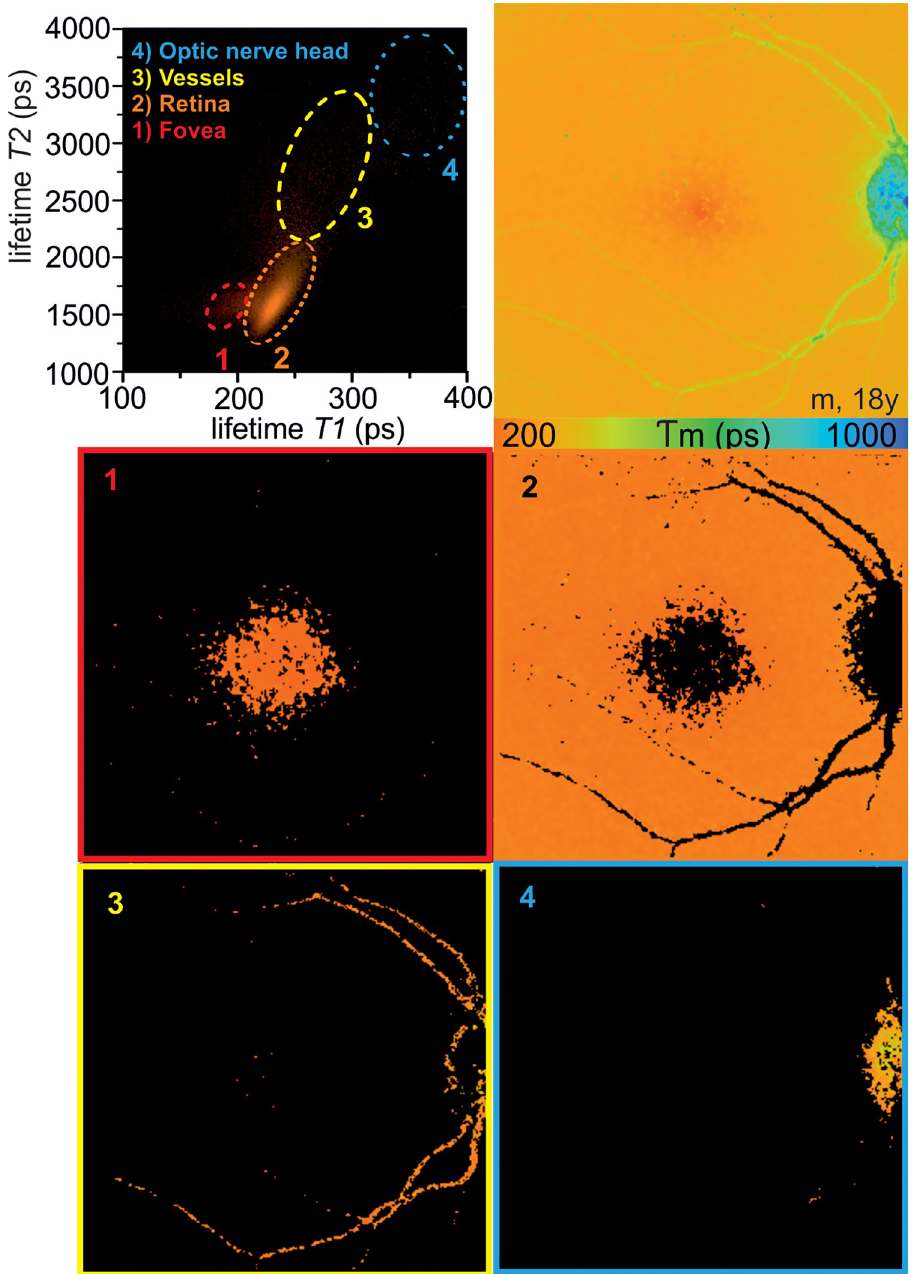
Fig 5. Scatter plot of fluorescence lifetime parameters. The scatter plot represents an illustrative way of depicting the interaction between the short and the long decay component within each channel. Data are shown for the long spectral channel of a phakic subject. Similar scatter plots were observed in the short spectral channel. Individual fluorescence lifetime clusters were identified and allocated to the macular center (1), the surrounding retina (2), the retinal vessels (3), and the optic nerve head